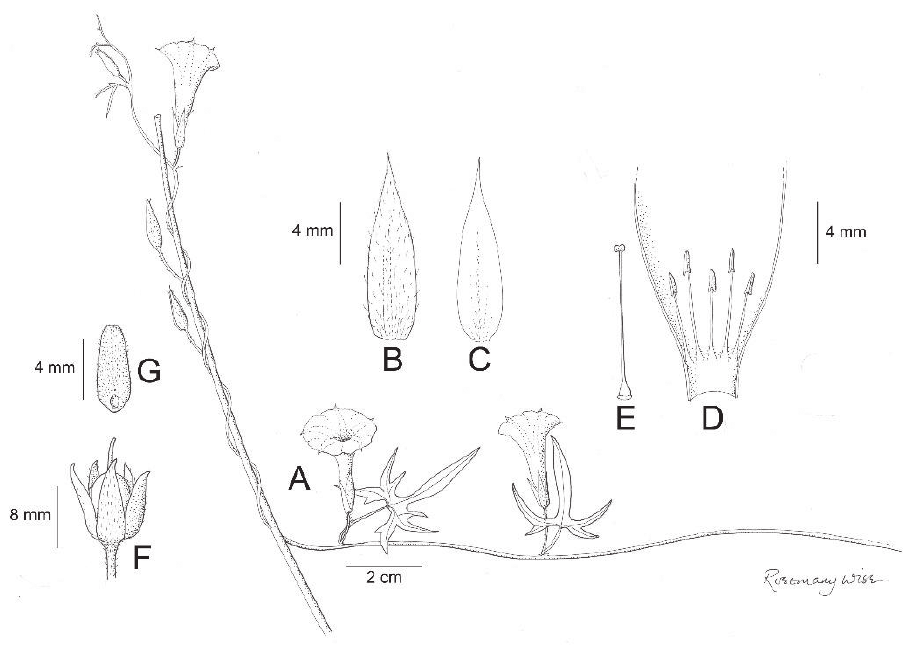
Figure 12. Ipomoea kraholandica . A habit B outer sepal C inner sepal D corolla opened out to show sta- mens e ovary and style F capsule and calyx G seed. Drawn by Rosemary Wise from A.A. Santos et al 719. lanceolate to oblong-lanceolate, the two laterals bifurcate or trifurcate with the lower lobe curved backwards whereas the upper and middle lobes (when present) are bent